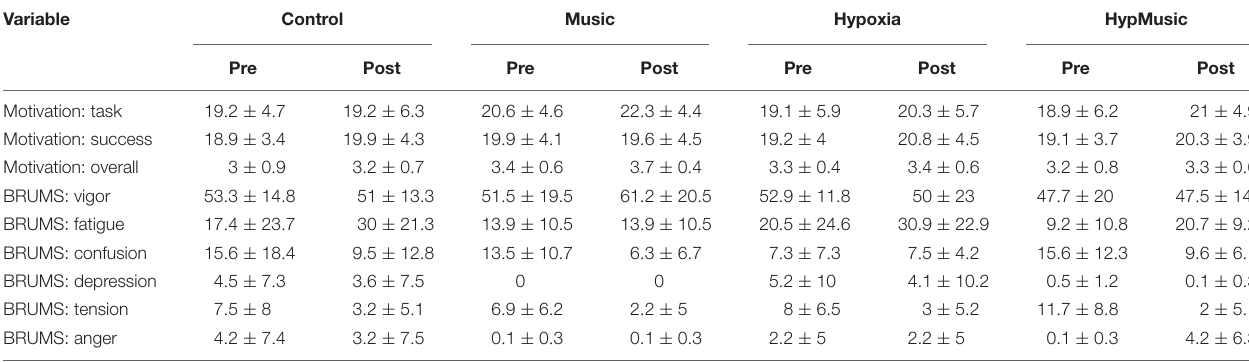
TABLE 2 | Subjective measures of motivation and mood. Variable Control Music Hypoxia HypMusic